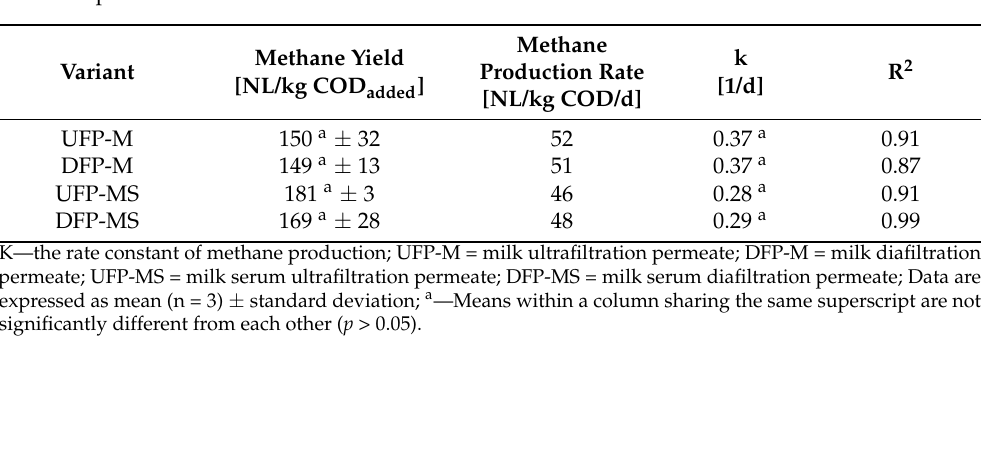
Table 4. Methane yield, methane production rate, and reaction rate constant (k) obtained in con- ducted